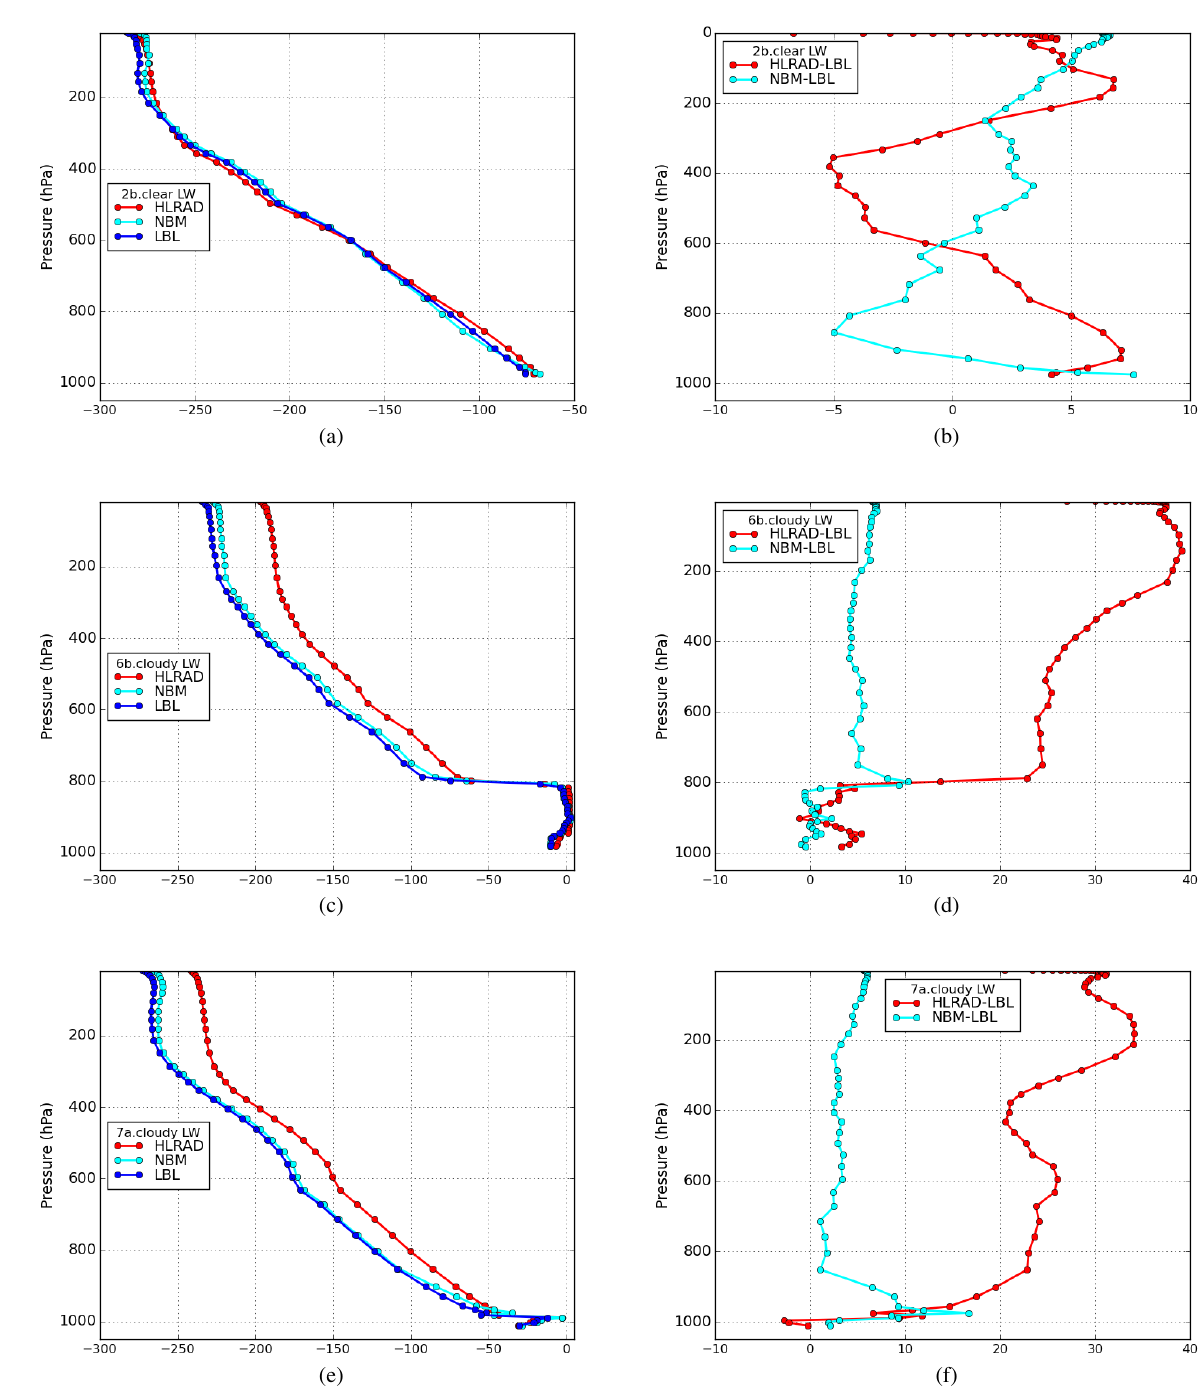
Figure 2. Net LW fluxes computed with LBL, HLRADIA and NBM (a, c, e) and the differences HLRADIA – LBL and NBM – LBL (b, d, f) : (a, b) for case 2b, (c, d) for case 6b and (e, f) for case 7a. Unit: Wm − 2